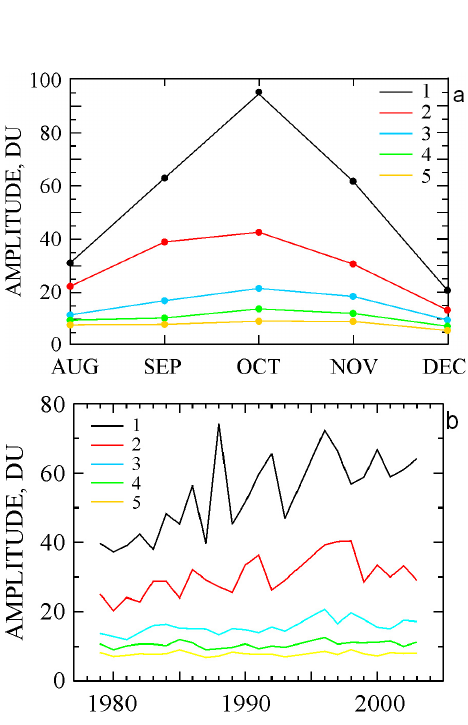
Fig. 6. Monthly mean amplitude of the wave numbers 1–5 averaged for the 1979–2003 period (a) and the interannual change of the 5- month mean amplitude (b)